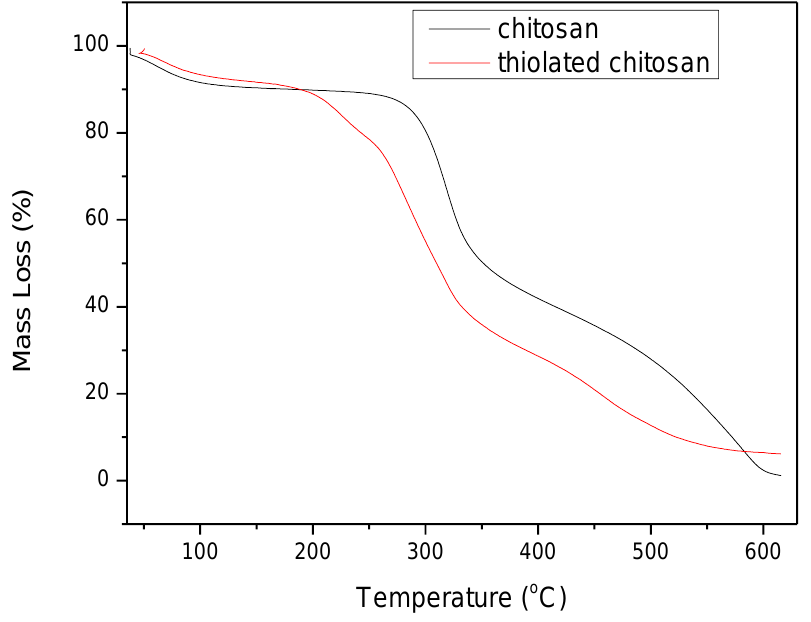
Figure 3. TGA thermograms of chitosan and thiolated chitosan.